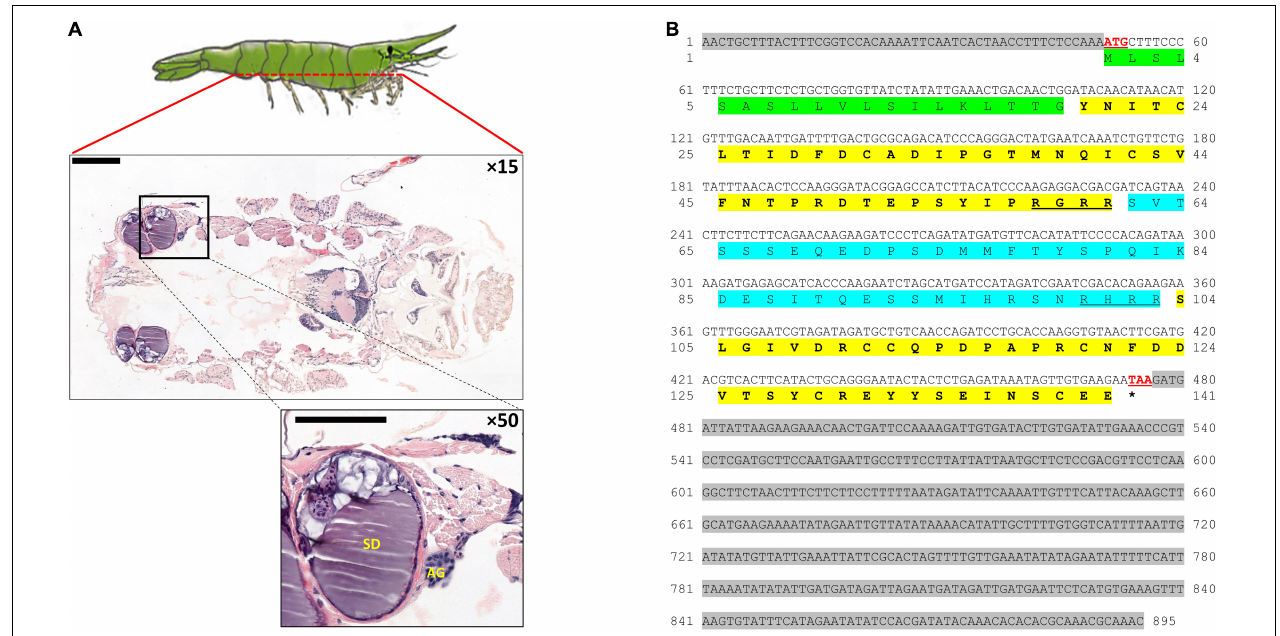
FIGURE 6 | AG and IAG in Hippolyte inermis . (A) Dorsoventral histological section ( × 15; top) of a H. inermis male stained with hematoxylin and eosin. The base of the fifth pereiopod is marked out with a black frame in which the androgenic gland (AG) and sperm duct (SD) are visible ( × 50; bottom). Bar scales (200 µ m) are given. (B) The full sequence of Hi-IAG mRNA and its open reading frame (ORF)-deduced amino acids. The signal peptide is highlighted in green. B chain (first) and A chain (second) are highlighted in bold on a yellow background, with C peptide (blue background), including its cleavage sites (underlined), flanked between them. The start (ATG) and stop (TAA) codons are shown in red and are underlined. The stop codon is also indicated with an asterisk. 5 (cid:48) (top) and 3 (cid:48) (bottom) UTRs are highlighted with a gray